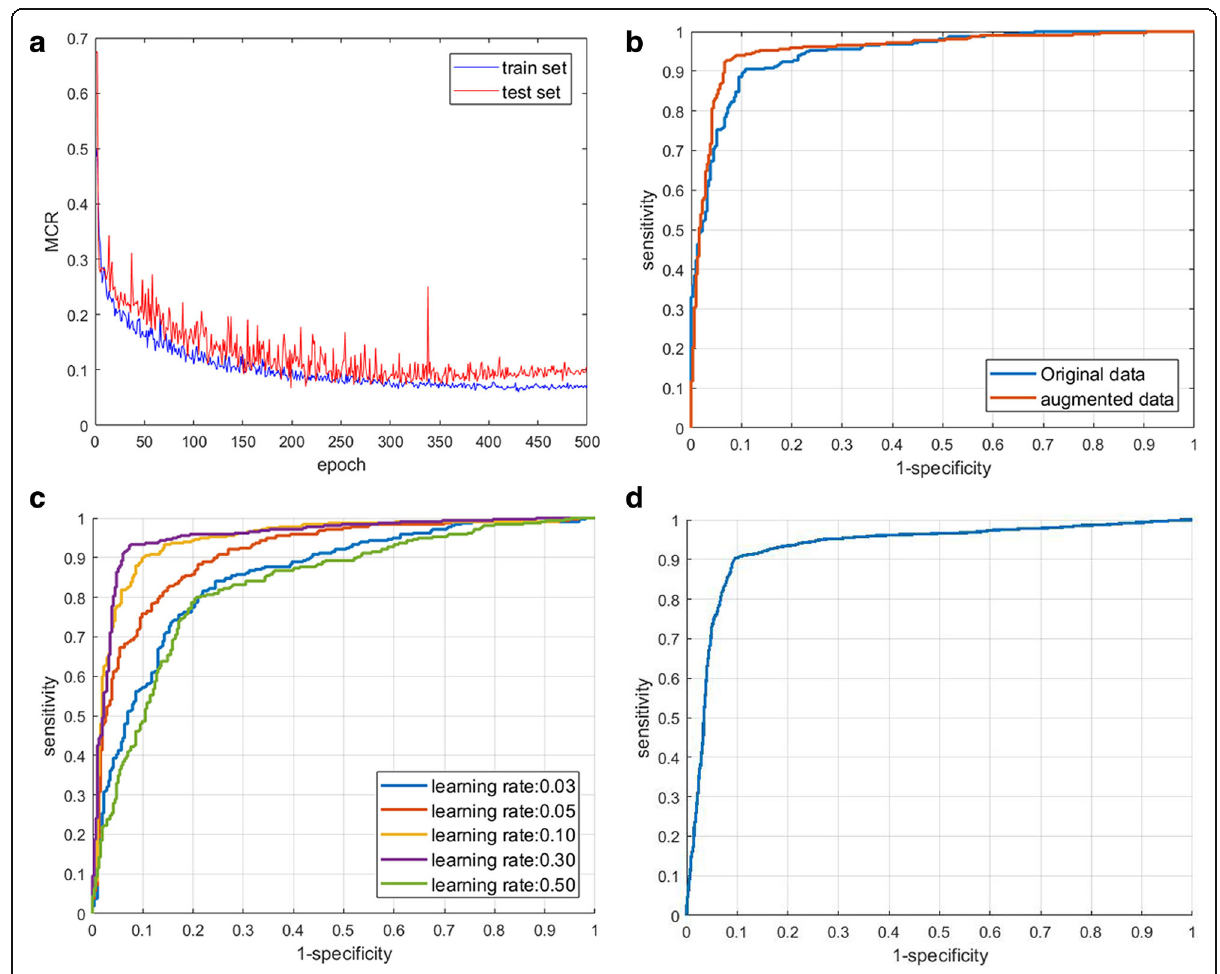
Fig. 3 a Misclassification rate curve of training set and testing set during training, b Receiver operating characteristic (ROC) comparison of original data and augmented data, c ROC comparison of convolutional neural network (CNN) with different learning rate, d ROC of CNN evaluated by a 10-fold